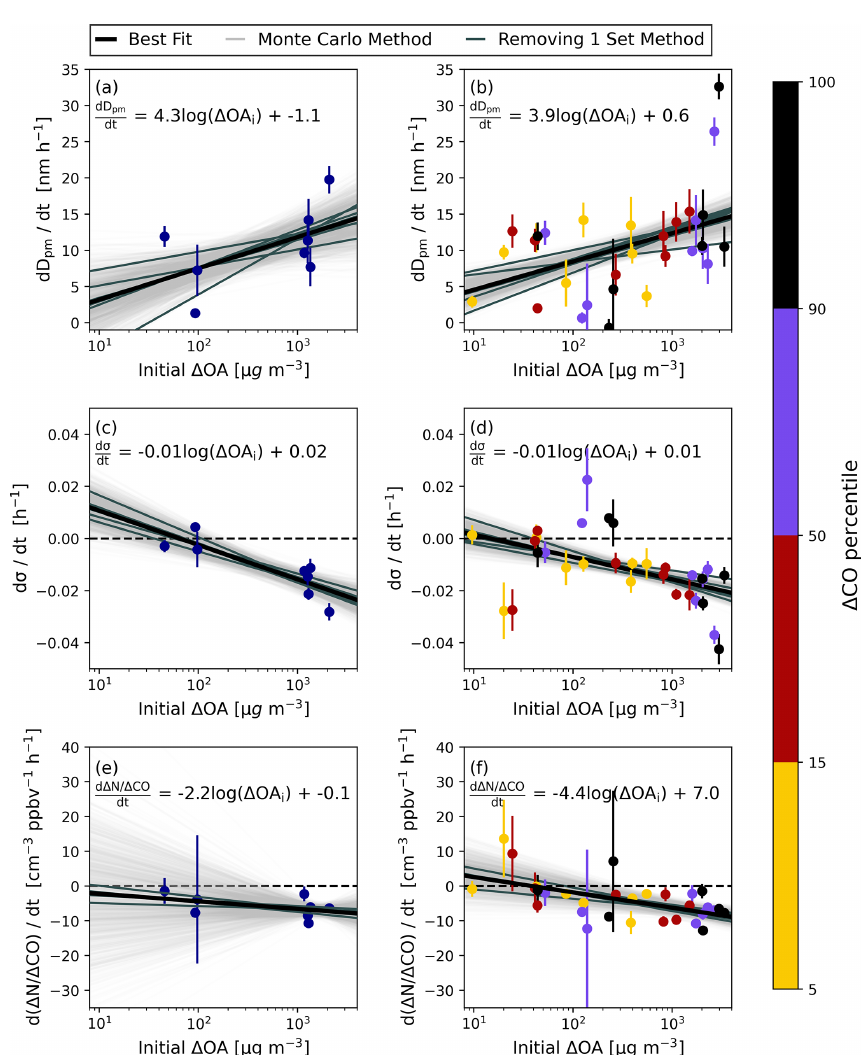
Figure 4. Observed average rate of change growth rate of the D pm (a–b) , σ (c–d) , and (cid:49)N/(cid:49) CO with smoke age for the eight sets of transects based on ordinary least-squares linear regressions as a function of log( (cid:49) OA i ) (initial background-corrected organic aerosol). Rates of change are for trends in the transect average values in (a) , (c) , and (d) and the (cid:49) CO (background-corrected CO) percentile ranges for each set of transects in (b) , (e) , and (f) . The error bars indicate the 95% confidence interval for the average rates of change on the y axis. A total of 1000 best-fit lines from a Monte Carlo technique are shown in light gray. The average and slope and intercept with their respective 95% confidence interval for the Monte Carlo fits are shown in Table S3. The darker gray lines are the results of linear regressions with one set of transects removed at a time. The solid black line is the linear regression for the points at the center of the error bars; the equation for this line is shown on each